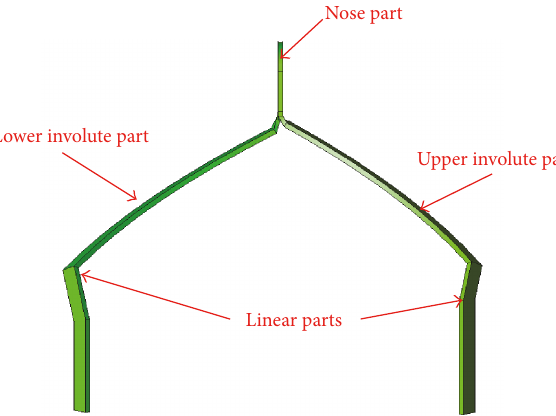
Figure 7: Definition of the parts of the end coil.